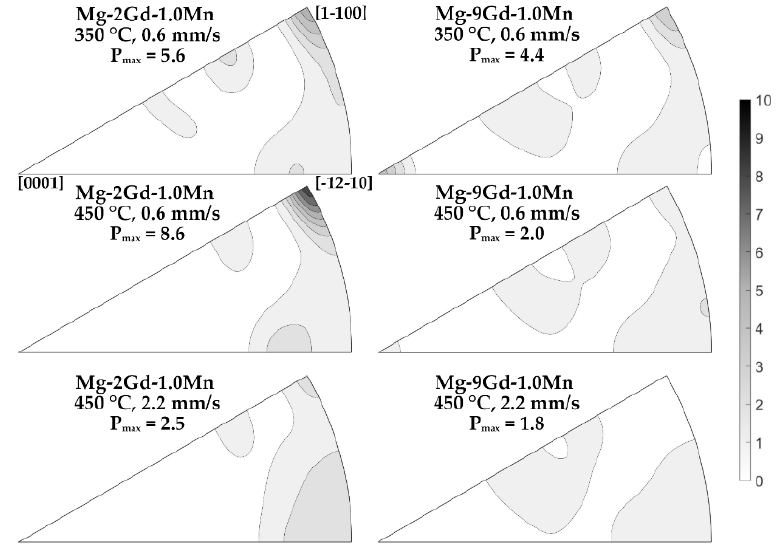
Figure 5. Inverse pole figures in ED of as extruded Mg-xGd-1Mn with respect to extrusion parameters. Bottom left [ 0001 ] pole, bottom right [ 1 ̅ 21 ̅ 0 ] pole and top right [ 11 ̅ 00 ] pole with intensities ranging from 0 to 10.